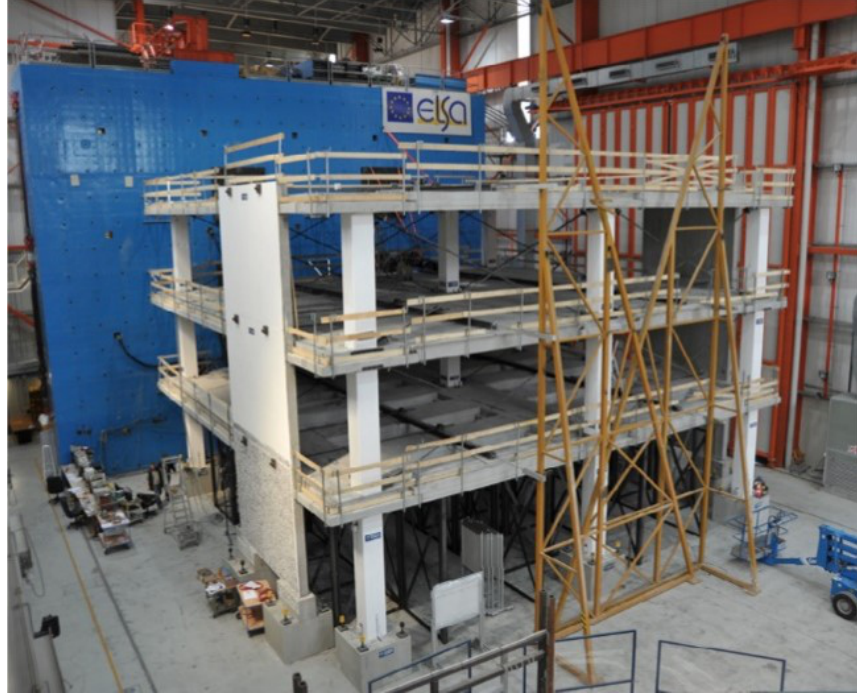
Figure 6. General view of the experimental precast building